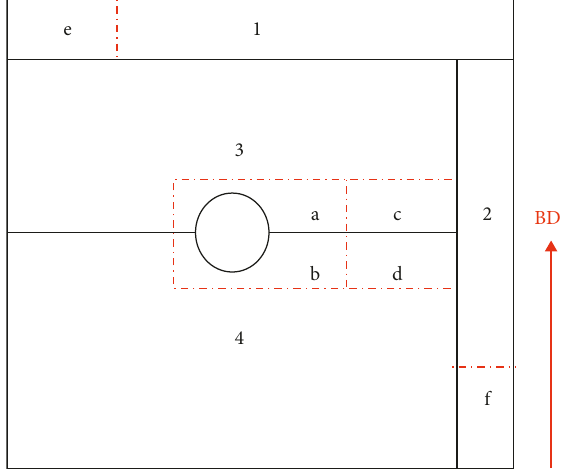
Figure 7: Lines of wire cutting of the Ti6Al4V target plates.